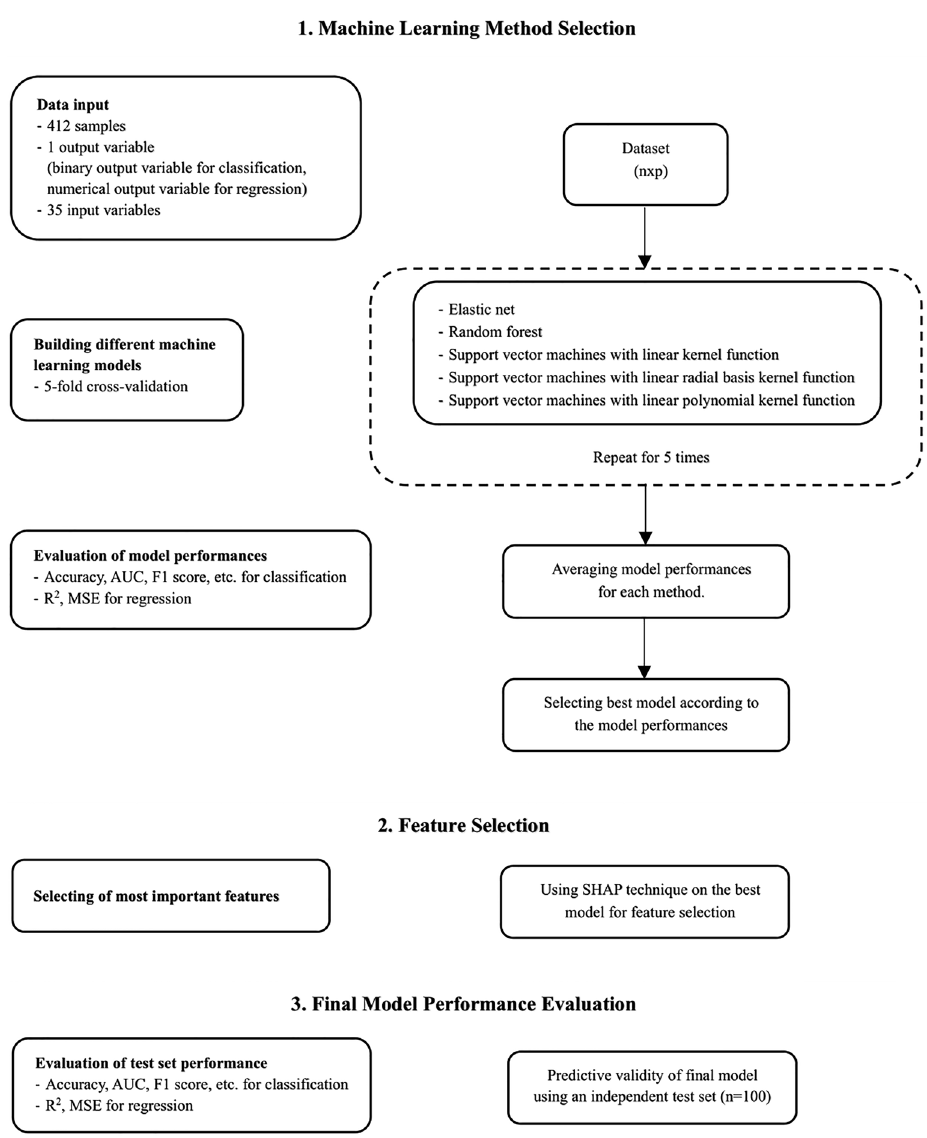
Figure 1. Flow chart of ML